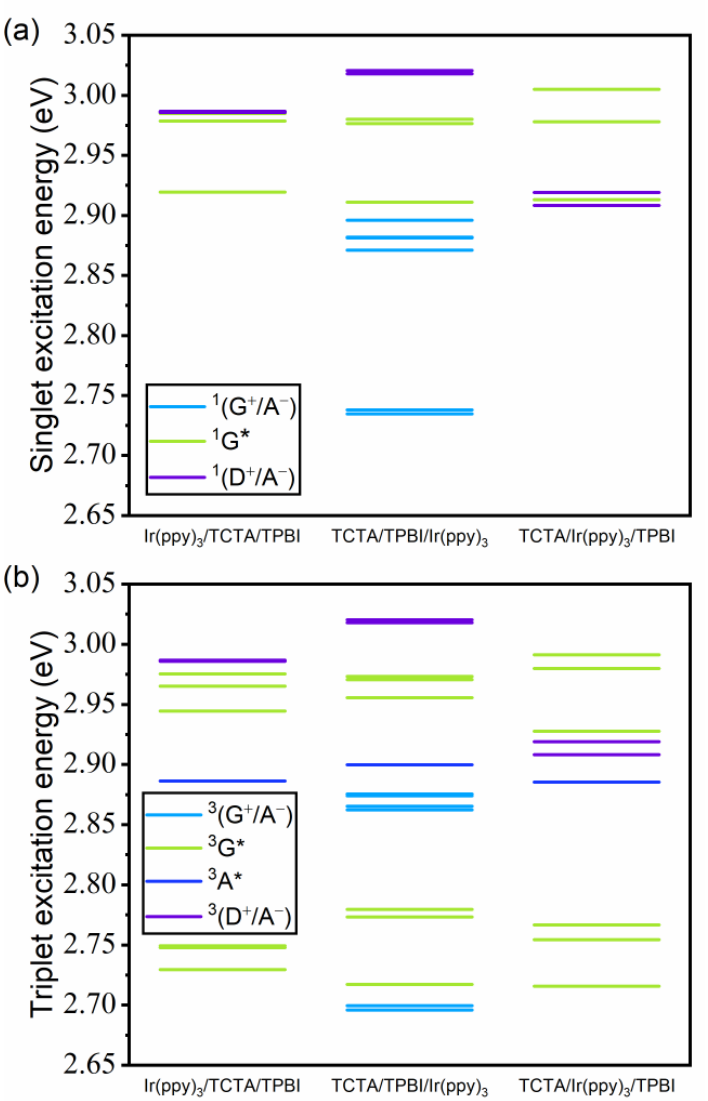
Figure 6. ( a ) Singlet and ( b ) triplet excited state energies of the three trimer model systems. In the legend, the three moieties are designated in a scheme of TCTA (electron donor) as D, TPBI (electron acceptor) as A, and Ir(ppy) 3 (guest) as G. For example, 3 (G + /A − ) shown in light blue represents a triplet CT state with an electron migrated from Ir(ppy) 3 to TPBI, and 3 G* in green represents a triplet locally excited state of Ir(ppy) 3 .